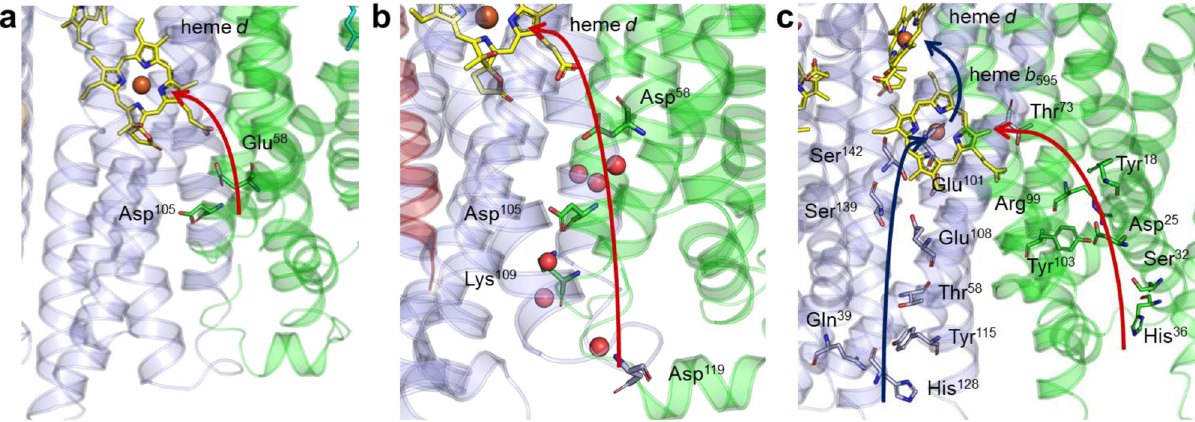
Fig. 7 Proposed proton pathways to heme d . a shows the short channel in bd -II that begins at the end of the large, hydrophilic cavity, b the longer proton pathway along a series of titratable amino acid residues in bd -I and c the two proposed extended proton pathway in G. thermodenitri fi cans bd oxidase 25 . Putative proton pathways are indicated by red arrows that connect titratable residues. The proposed second pathway in G. thermodenitri fi cans bd oxidase is indicated by a blue